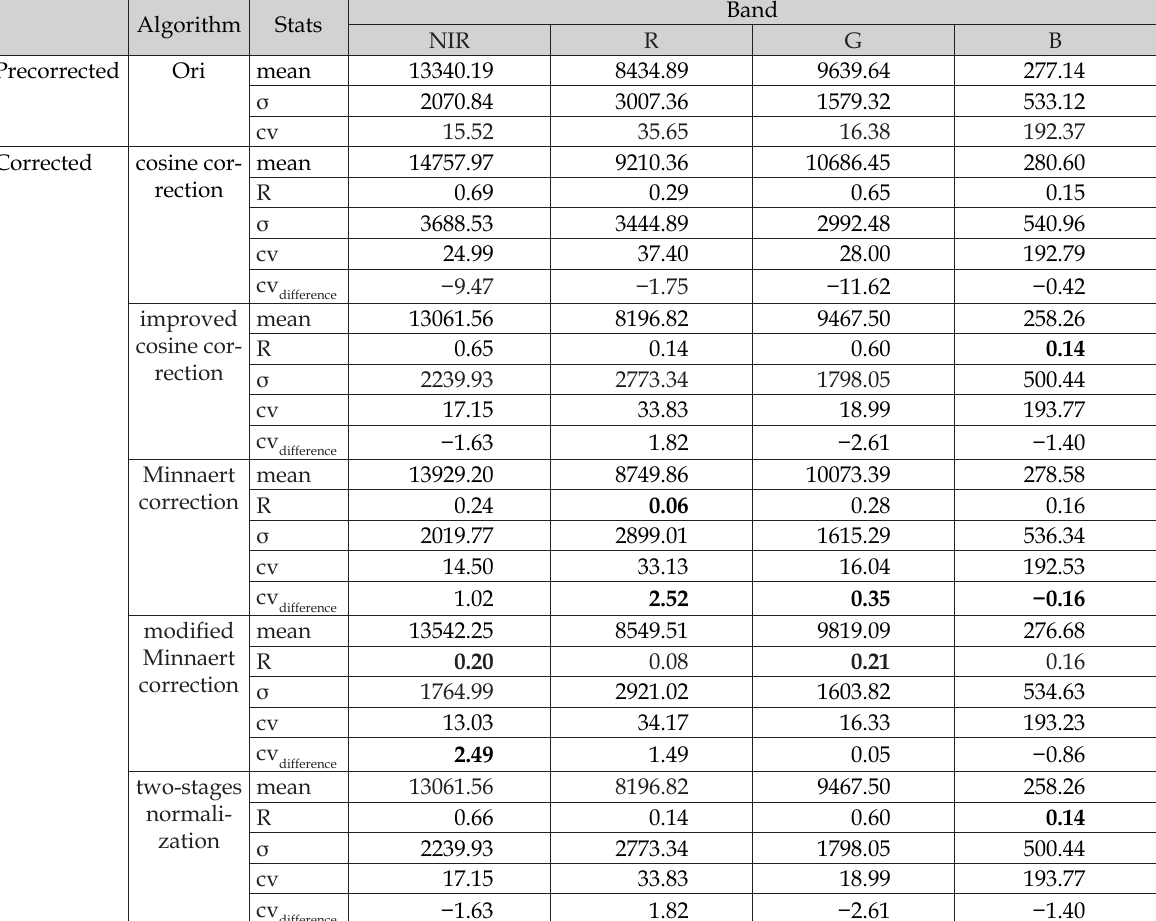
Table 1. Statistics of pixel value before and after topographic correction. A negative value indicates an increase in coefficient variation after correction. Bold and highlighted value indicated the best performed algorithm (σ is the standard deviation, cv is the correlation coefficient, and R is the correlation